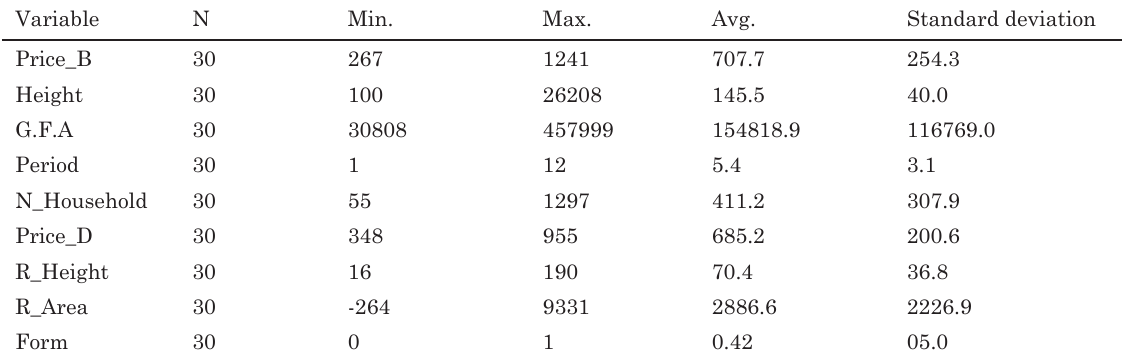
table 6. basic statistics